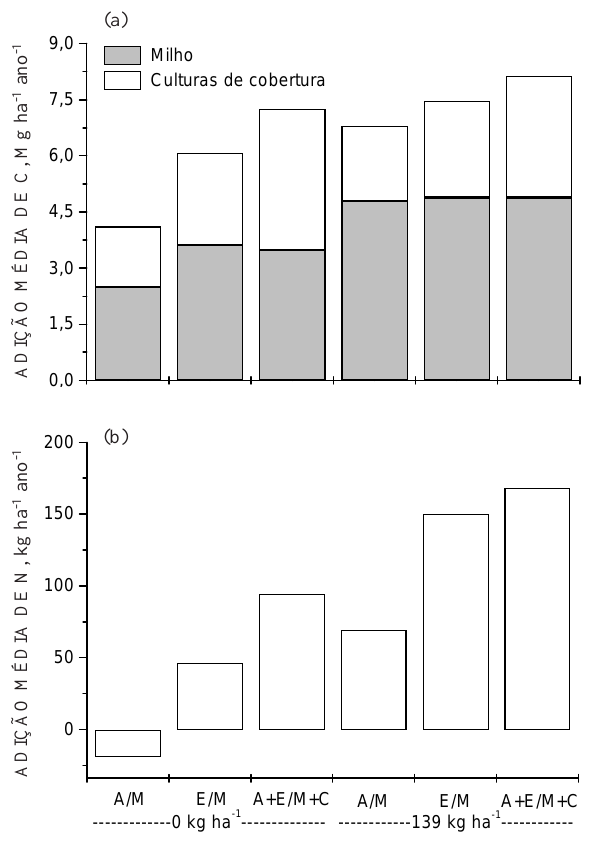
Figura 1. Quantidades anuais médias de C (a) e de N (b) adicionadas ao solo pelos sistemas de culturas, em duas doses de N mineral. Valores médios de três sistemas de preparo de solo no período de 1985 a 1998. N adicionado = (N adubo + N fixado simbioticamente)-N retirado na colheita. A = aveia, M = milho, E = ervilhaca, C =